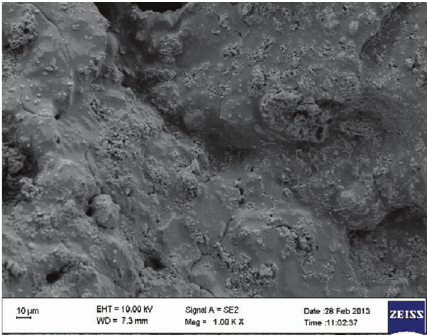
Figure 3: SEM image of ammonium nitrate with 600ppm sulfuric acid.